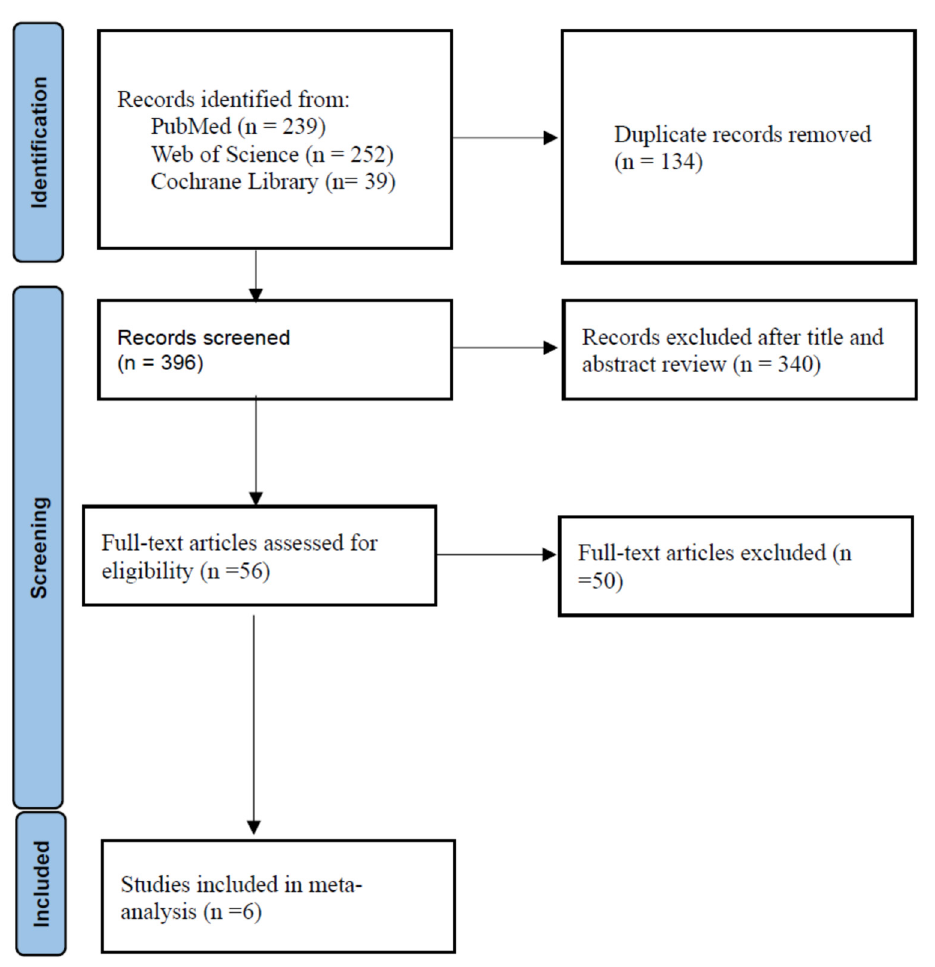
Figure 1. Flow diagram of the study selection process. Six studies were included in the meta-analysis, including one randomized controlled trial, five retrospective observational